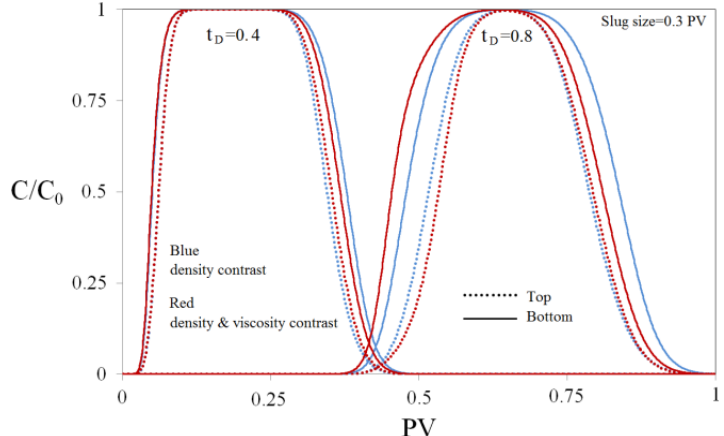
Figure 7. Concentration ratio at t = 0.4 and t = 0.8 for the injected slug at the top D D (dashed lines) and the bottom (solid lines) of the sand-pack. The results are shown for two different solutions: first one (blue lines) has only density ratio = 1.2 with the sand-pack initial water, while the second one (red lines) has both density ratio = 1.2 and viscosity ratio = 1.3 with the sand-pack initial